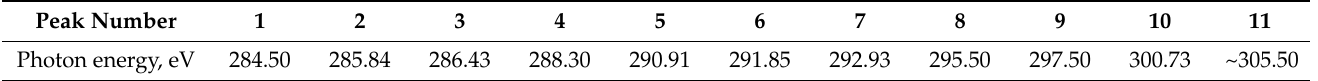
Table 1. Energy positions of absorption bands in C 1s NEXAFS spectrum of C 60